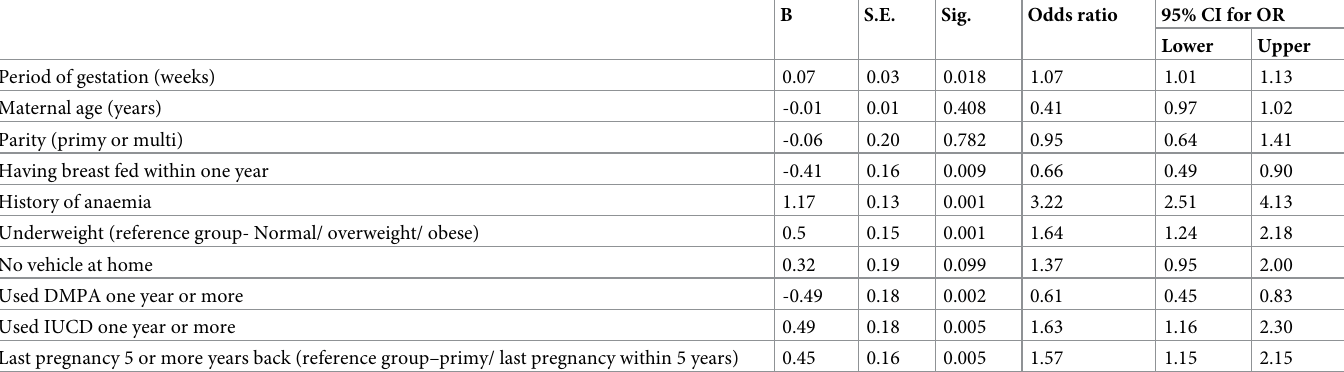
Table 3. Hierarchical logistic regression explaining anemia in first-trimester pregnant women in Anuradhapura district.